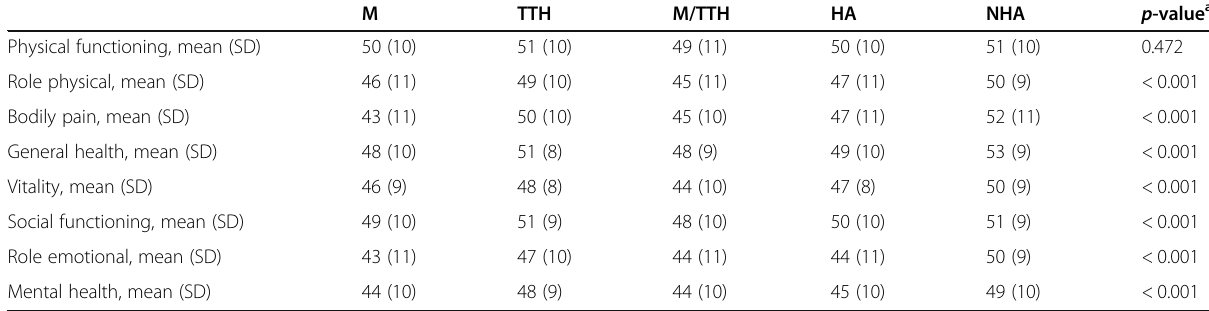
Table 2 Norm-based scoring of SF-12v2